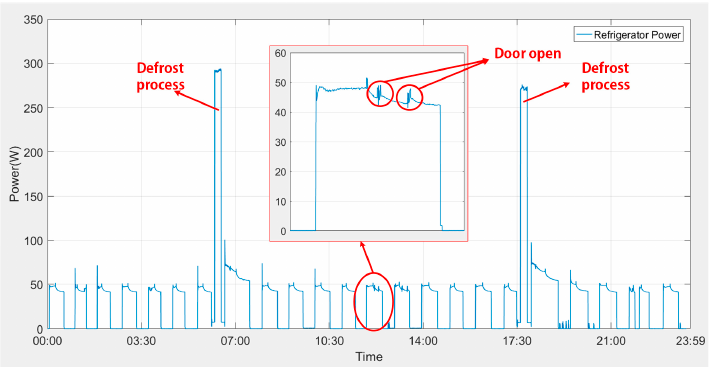
Figure 4. The daily power consumption of the refrigerator.